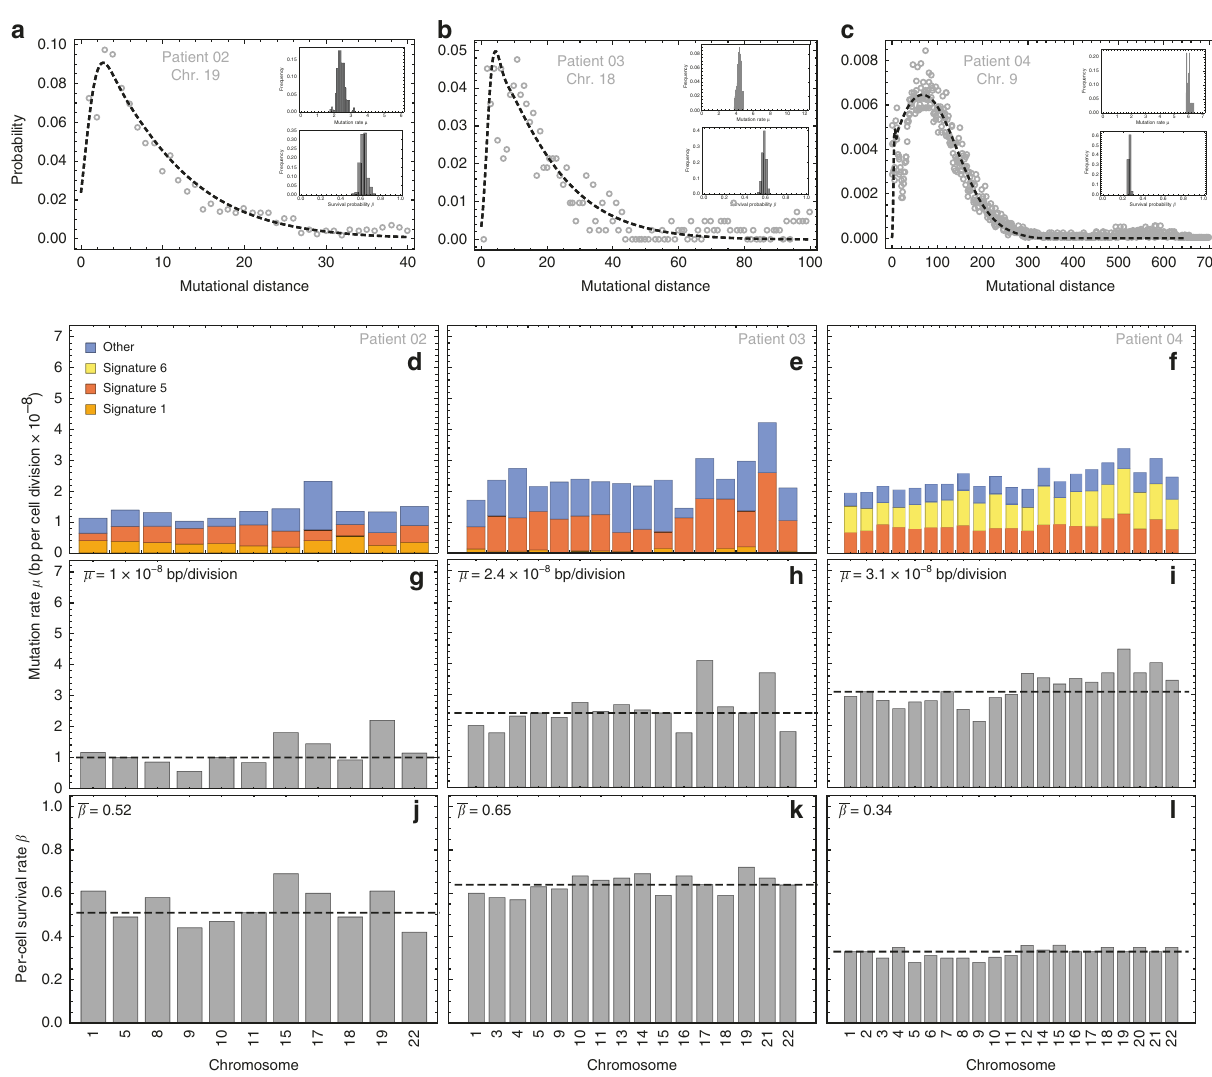
Fig. 5 Mutational distance for three colorectal tumours. a – c Examples of the mutational distance distribution on single chromosomes for three different colorectal carcinomas for which 6, 7 and 9 multi-region bulk samples were sequenced at whole-genome resolution (dots = data, dashed line = theoretical prediction based on MCMC parameter estimates — see insets). The distribution of mutational distances differs between patients, with Patient 04 (MSI Microsatellite Instability) showing one order of magnitude larger mutational distances. d – f Per-cell mutation rate per chromosome separated by trinucleotide mutational signature. Results are consistent across chromosomes, as expected (Methods). g – i The mean overall mutation rates are (cid:6) (cid:6) (cid:7) μ ¼ ð 1 : 0 þ 0 : 46 Þ ´ 10 (cid:2) 8 ; μ ¼ ð 2 : 4 þ 0 : 41 Þ ´ 10 (cid:2) 8 and μ ¼ 3 : 1 þ 0 : 35 ´ 10 (cid:2) 8 bp = division , dashed lines), 20 – 60 times higher compared to healthy somatic (cid:2) 0 : 07 (cid:2) 0 : 19 (cid:2) 0 : 12 02 03 04 cells. Patient 04 is MSI + highlighted by signature 6. j – l Estimates of per-cell survival rates per chromosome are consistent across chromosomes of the ¼ 0 : 51 þ 0 : 05 ; β ¼ 0 : 65 þ 0 : 02 ; β ¼ 0 : 34 þ 0 : 01 same patient (Median: β (cid:2) 0 : 05 (cid:2) 0 : 02 (cid:2) 0 : 01 ), but vary considerably between patients (Supplementary Fig. 02 03 04